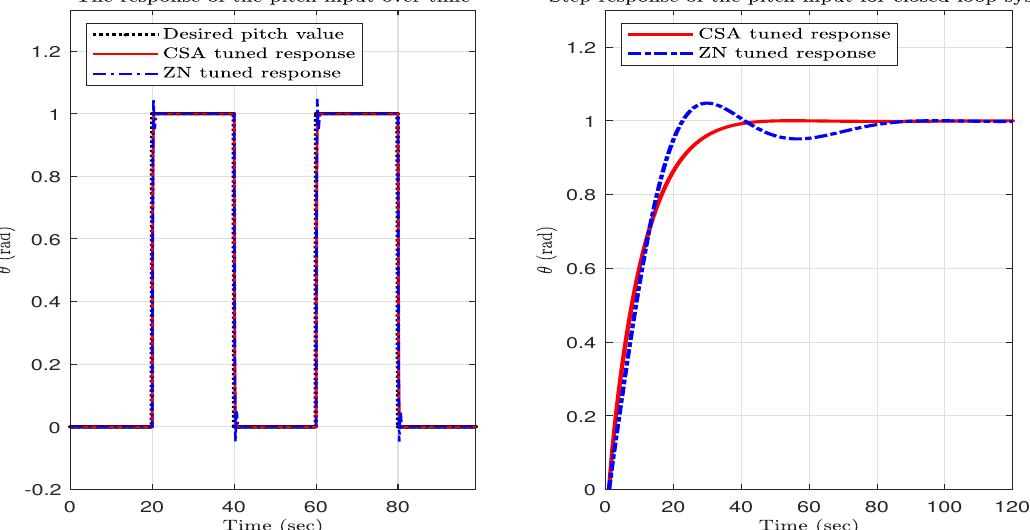
Figure 16. Simulated output responses of the pitch input of a quadcopter using CSA and ZN methods.